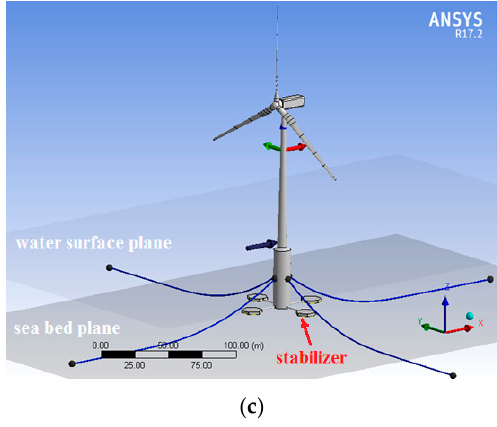
Figure 4. Wind turbine models used in numerical tests—( a ) before using any stabilizer; ( b ) using a single plate; and ( c ) using a four-wing stabilizer.